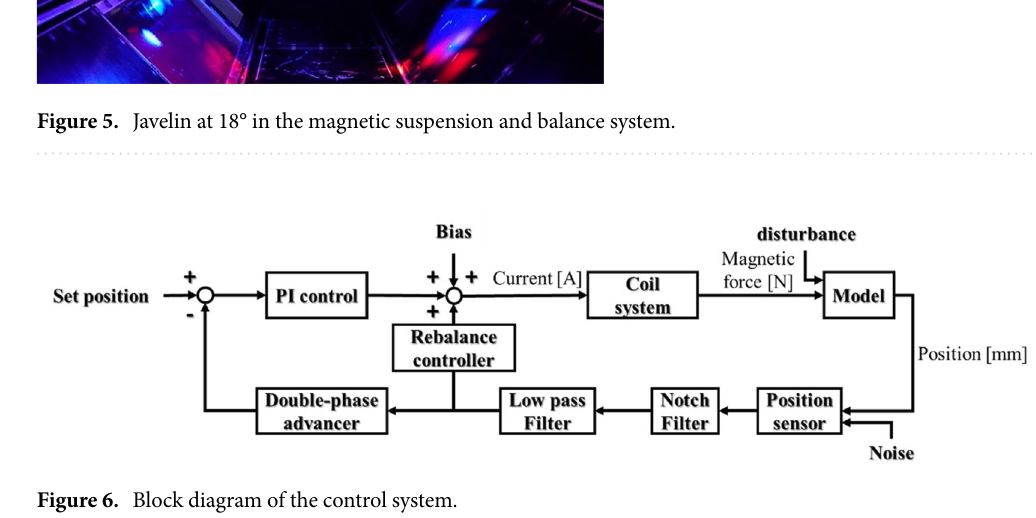
Figure 6. Block diagram of the control